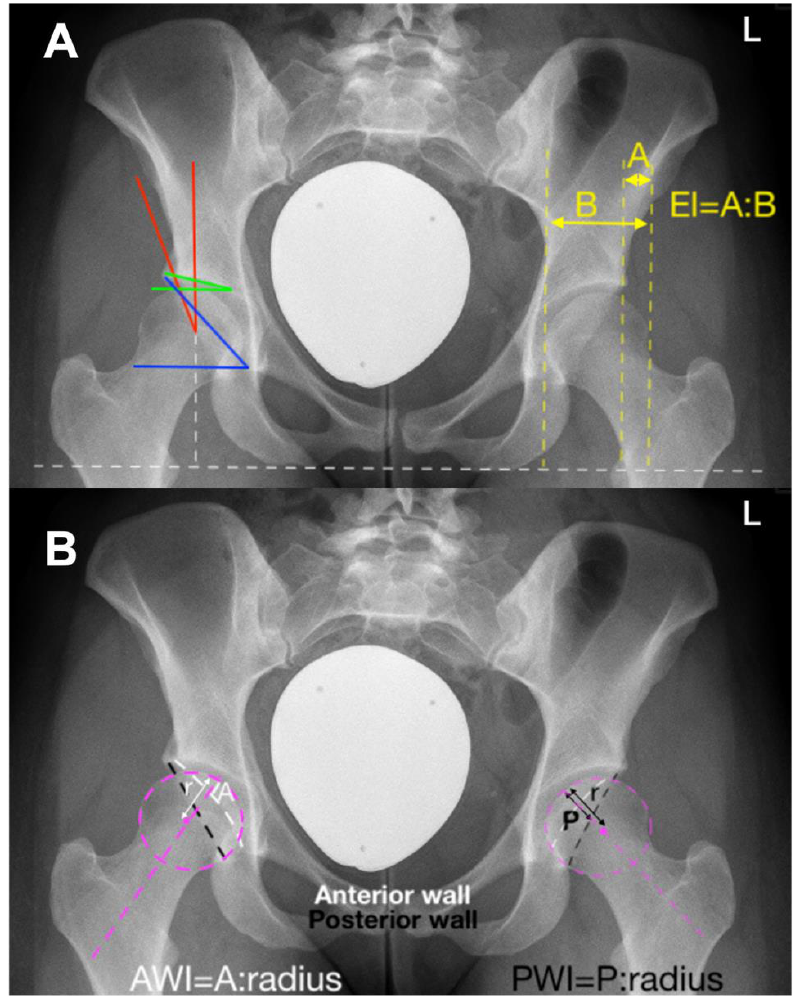
Figure 2. A 24-year-old female with a symptomatic DDH on the right side. Radiological criteria: ( A ) Lateral center edge angle (LCEA) (red): 18.9 ◦ , Acetabular index (green): 12.7 ◦ , Sharp angle (blue): 47.5 ◦ ; Extrusion index (EI) (yellow): 22.6%. ( B ) Anterior wall coverage (AWI): 16.2%, Posterior wall coverage (PWI):